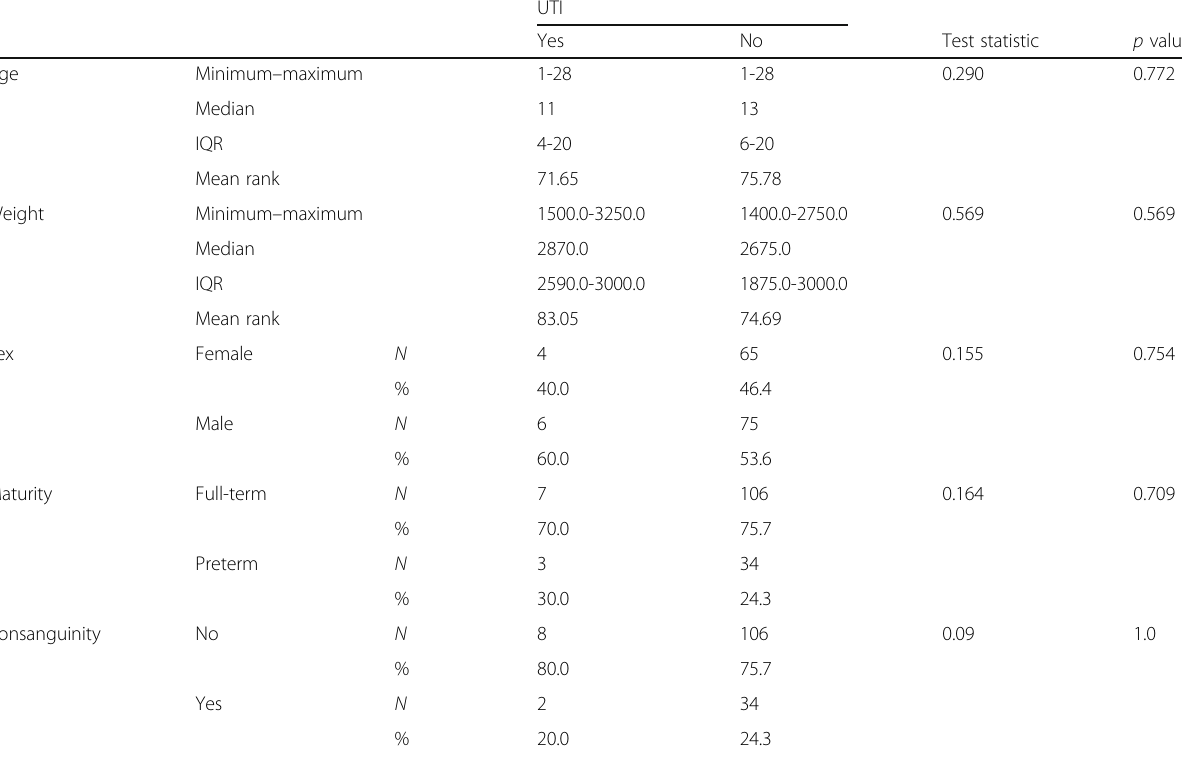
Table 4 Association of demographic characteristics, maturity, consanguinity, and urinary tract infection